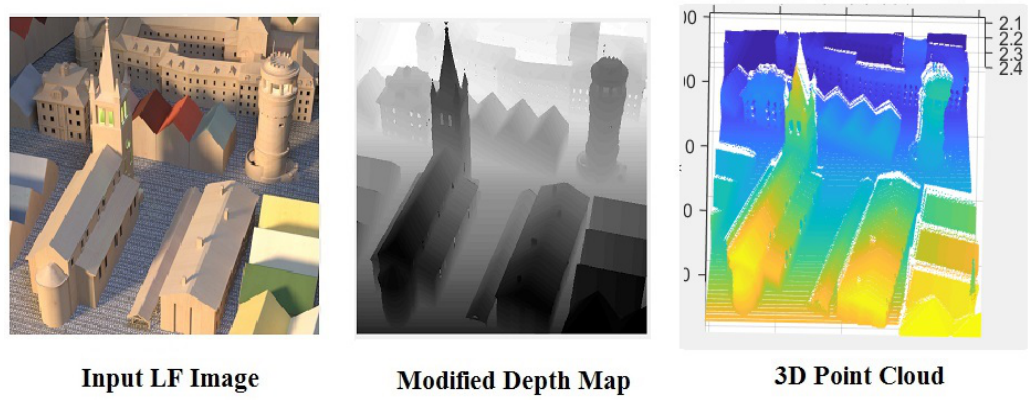
Figure 1. Using a light field image for creating a 3D point cloud.